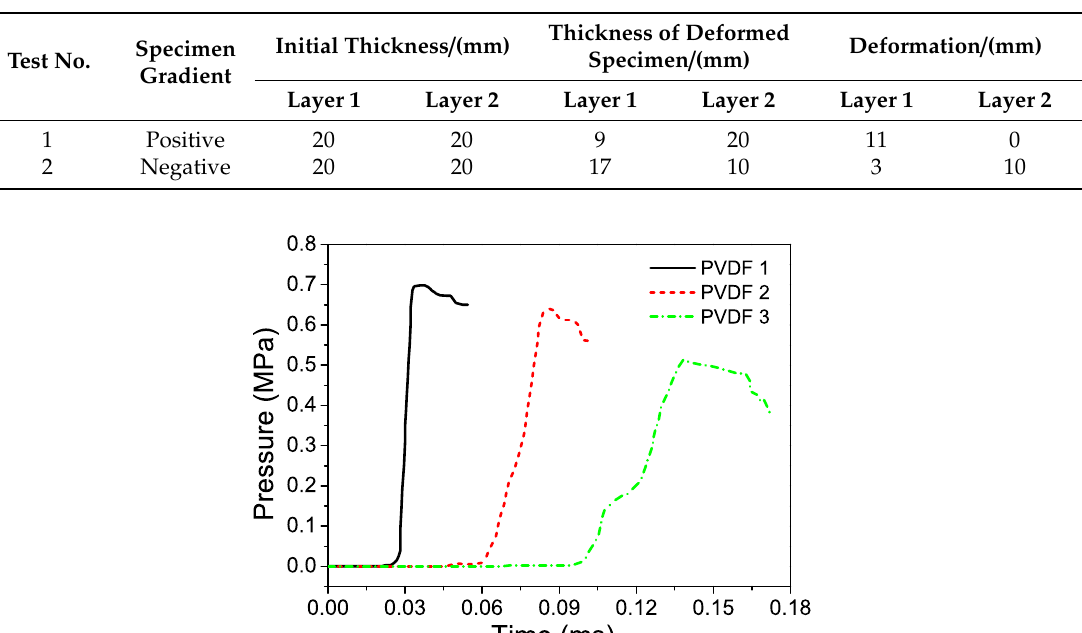
Figure 4. Cross-sections of deformed specimens. Table 3. Deformation dimensions of deformed specimens.